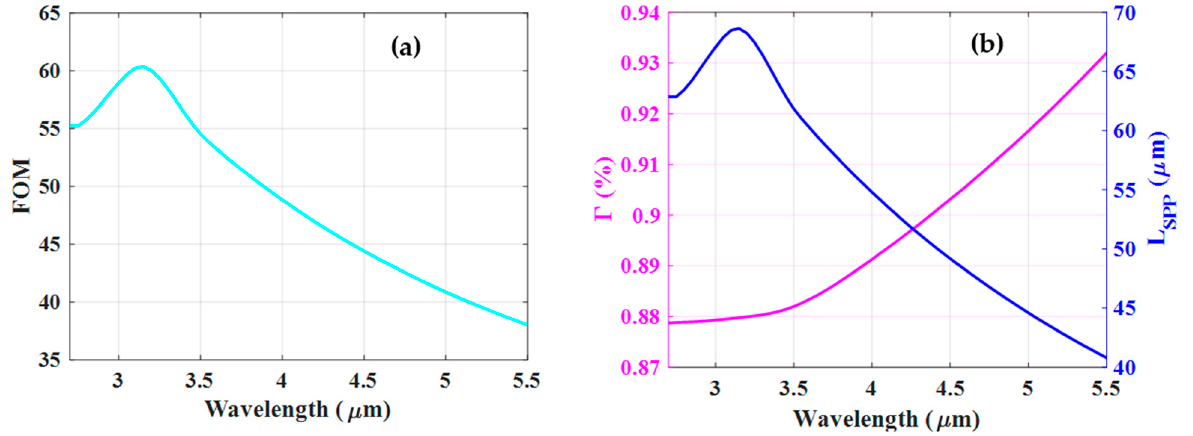
Figure 9. ( a ) The FOM of the optimized plasmonic slot waveguide ( w = 50 nm, h = 200 nm) as a function of the wavelength. ( b ) The corresponding confinement factor and propagation length.